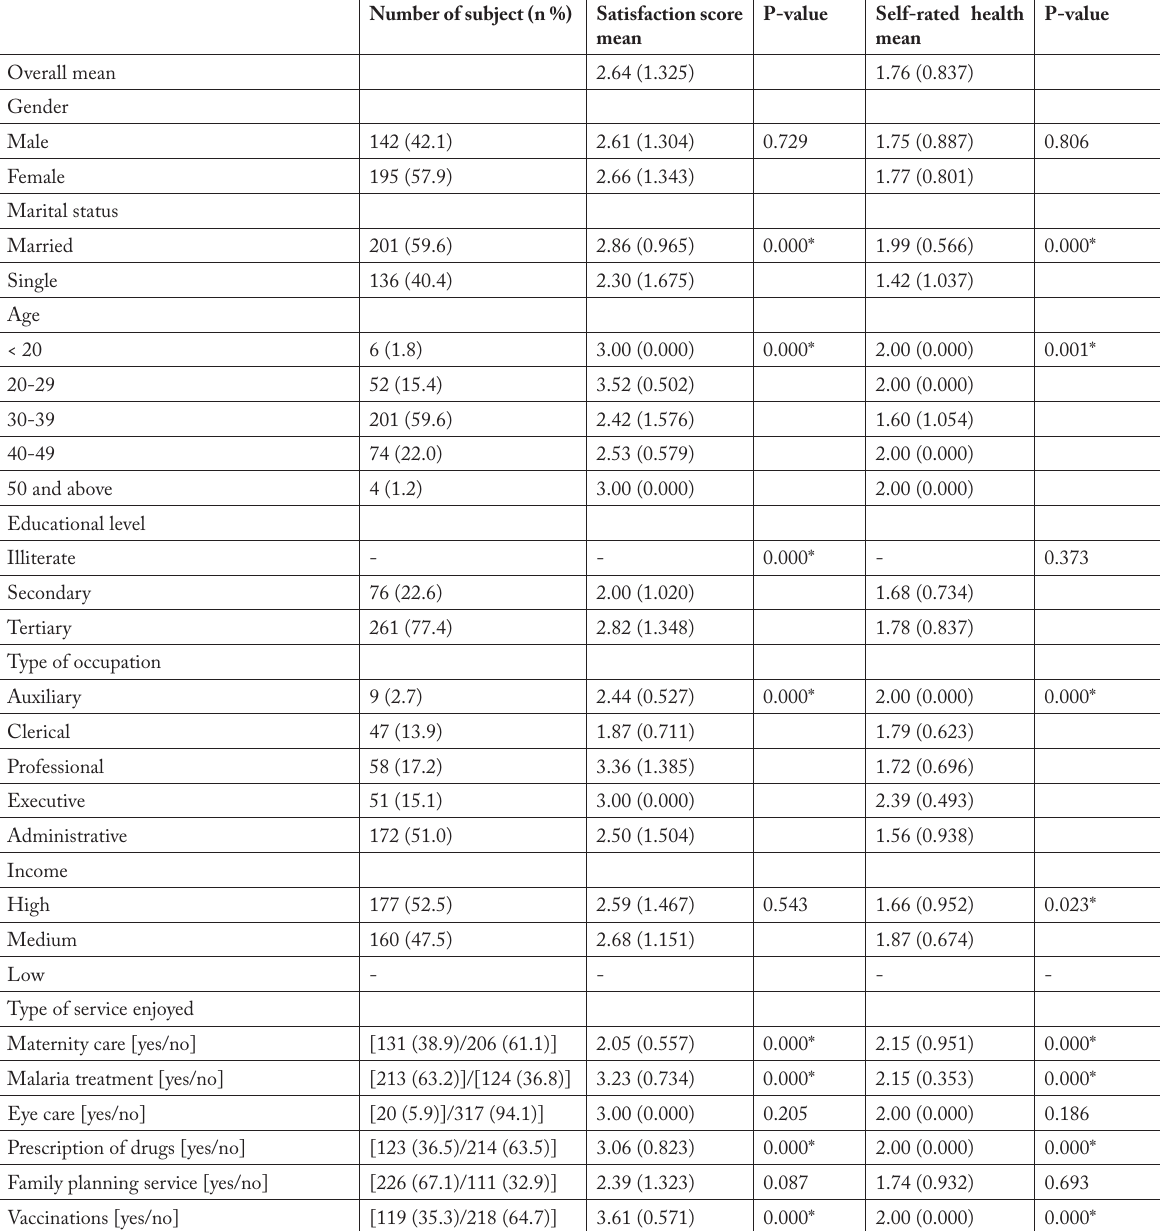
Table 1. Comparison of mean satisfaction and self-rated health scores according to the socio-demographic characte- ristics and type of service used by ANOVA method ( n =